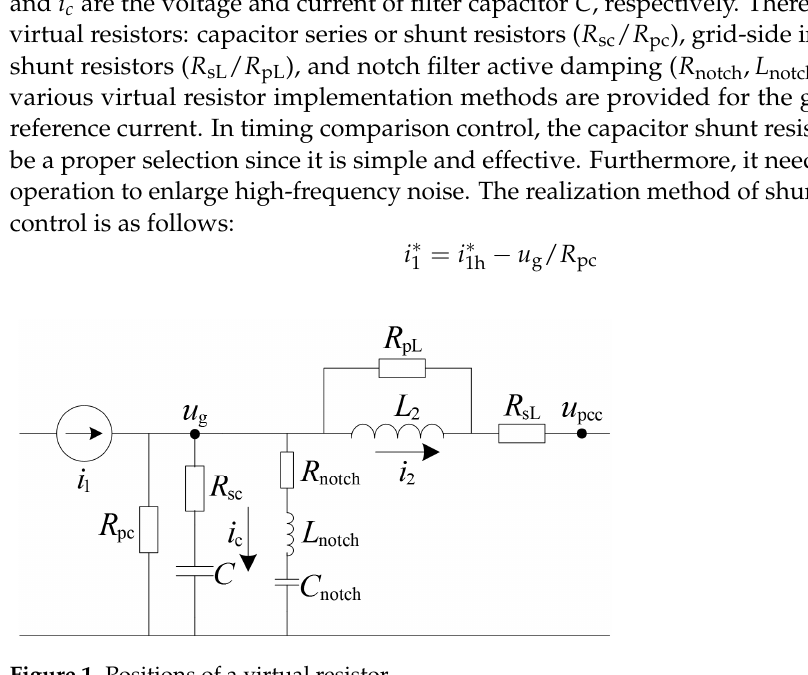
Figure 1. Positions of a virtual resistor.